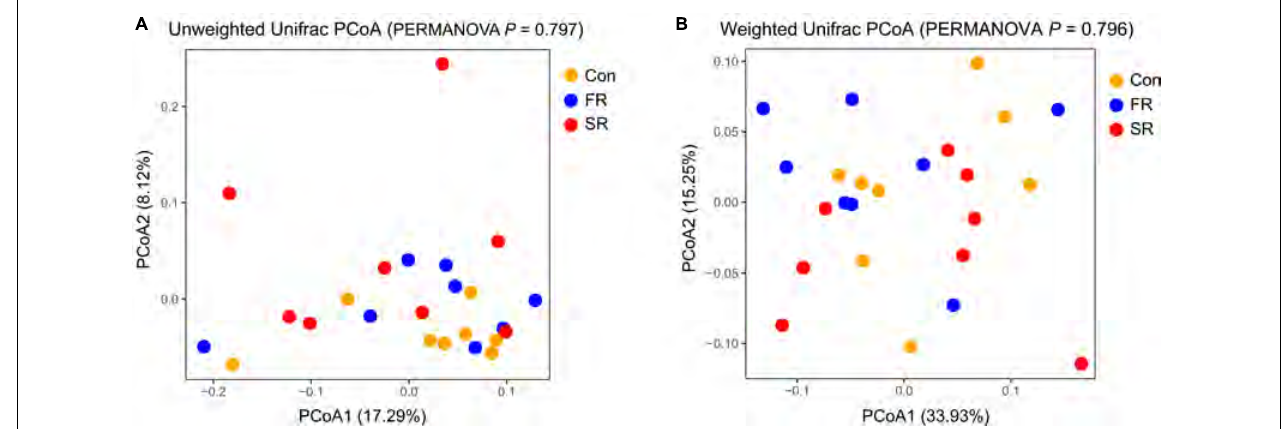
FIGURE 1 | Principal Coordinate Analysis (PCoA) of fecal microbial community based on unweighted (A) and weighted Unifrac distance (B) . PERMANOVA anaysis with 999 permutations is shown. Con, saline; FR, fresh rumen fluid; SR, sterilized rumen fluid.